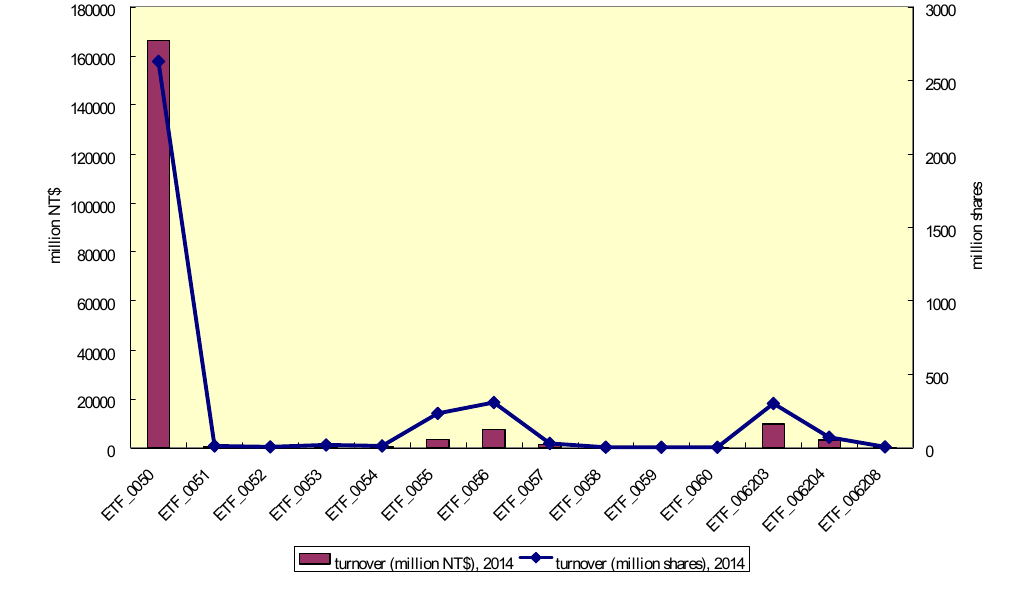
Fig. 1. 2014 turnovers of the 14 ETFs on TWSE